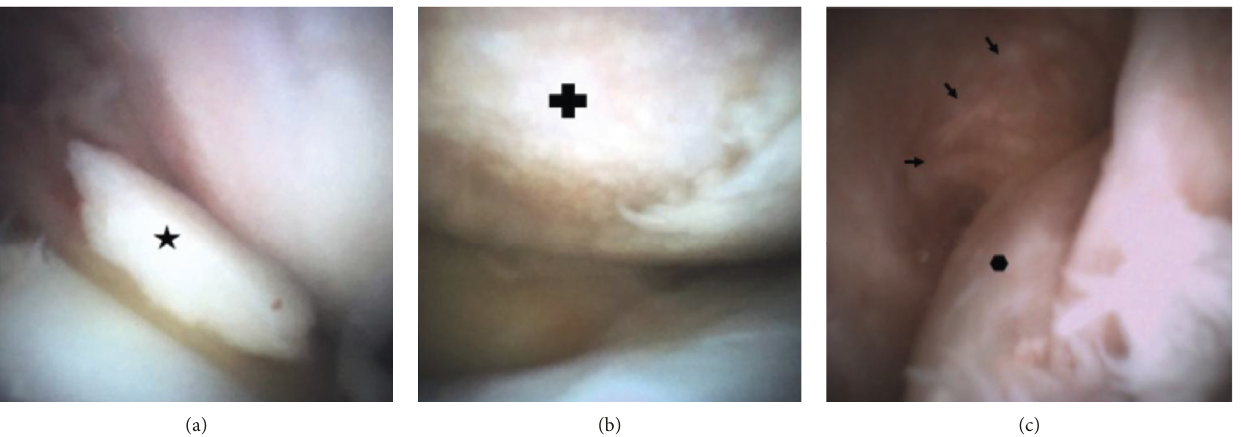
Figure 4: Arthroscopic images of the right knee obtained with mi-eye 2. (a) An intra-articular loose body ( ) is visualized in the anterior knee. (b) A large chondral defect ( ) on the weight-bearing surface of the medial femoral condyle with complete loss of the articular cartilage and exposed subchondral bone. (c) A view of the intercondylar notch showing a tear of the ACL ( ) with the remnant fibers of the femoral origin (arrows) along the lateral wall of the